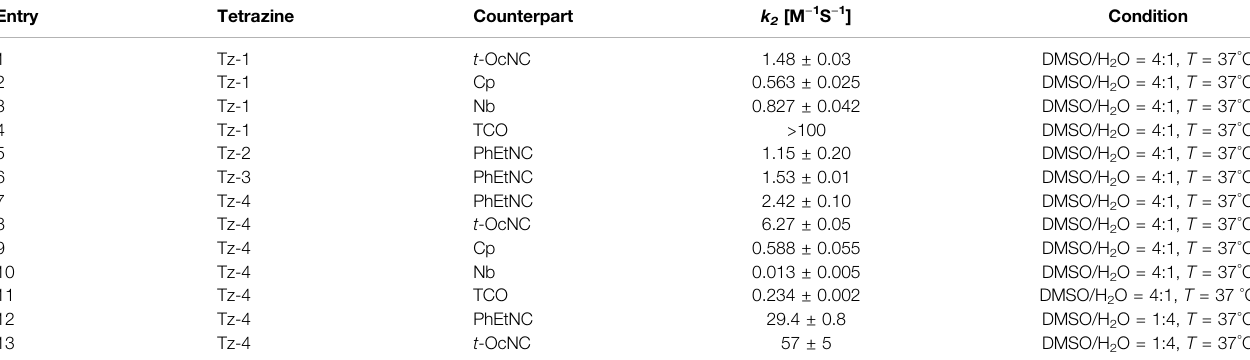
TABLE 1 | Second-order rate constants of reactions between tetrazines and different counterparts (structures of these compounds are shown in Supplementary Material ). Entry